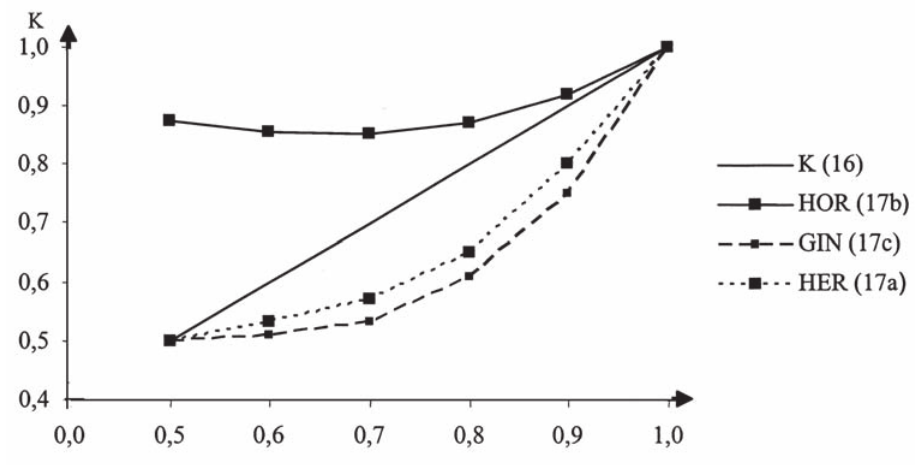
Fig 4. Graphical representation of concentration measures,